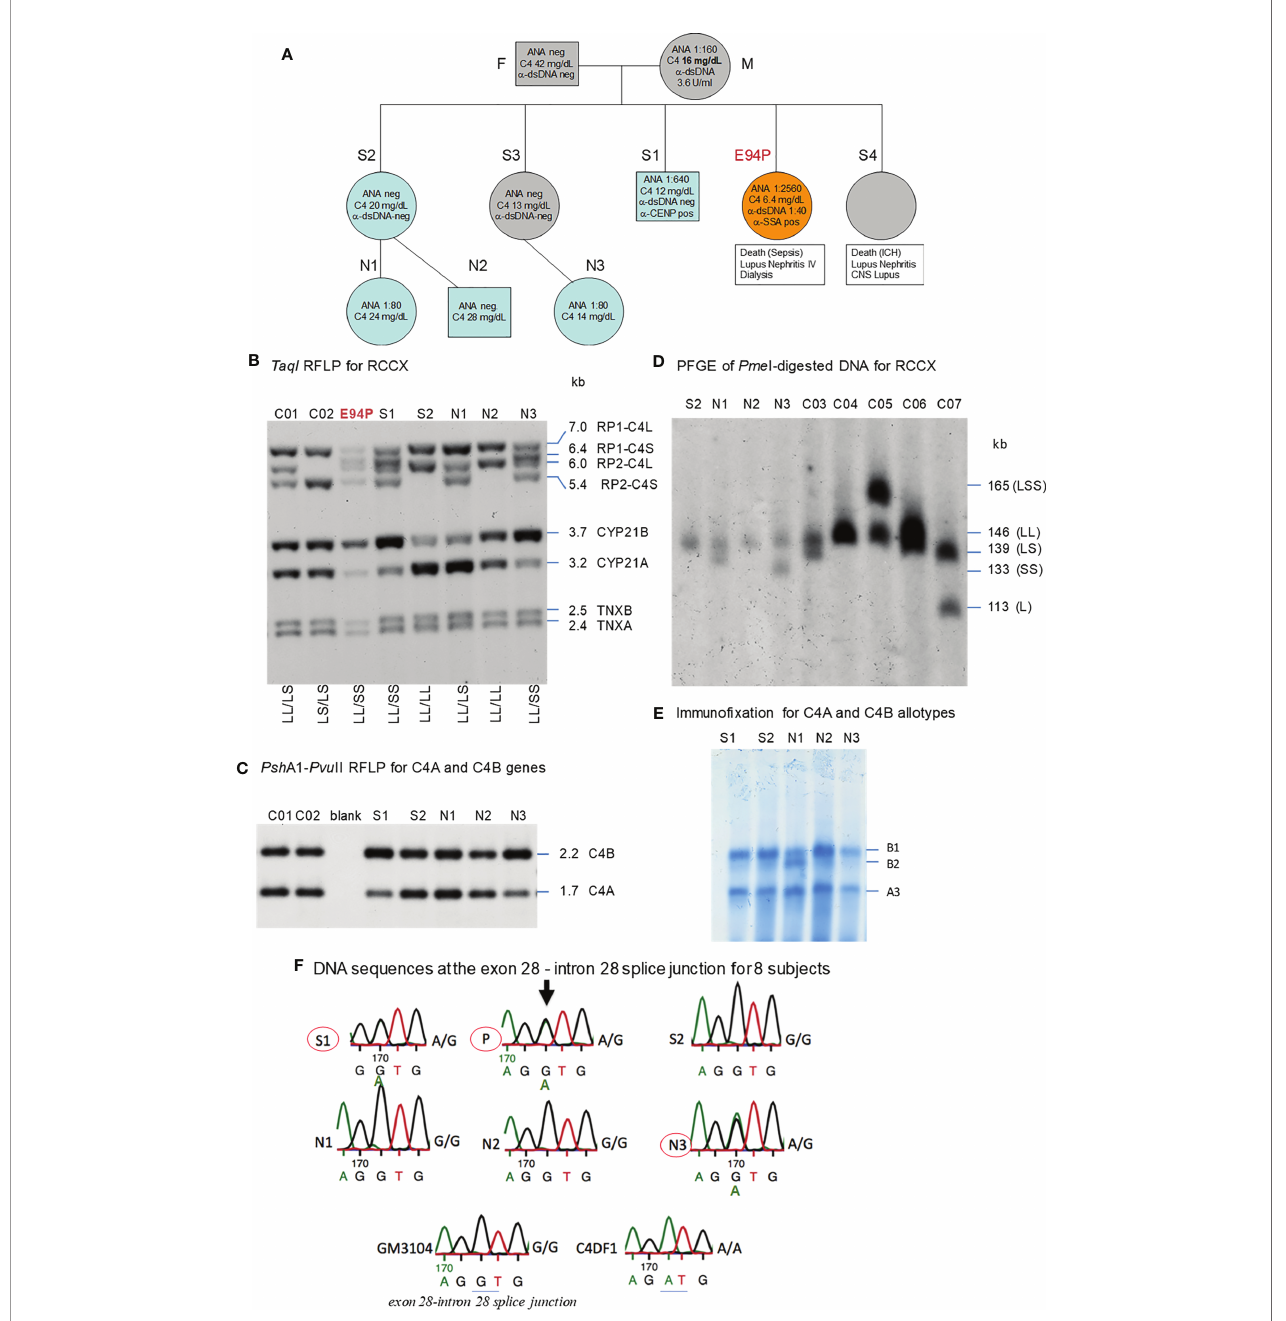
FIGURE 5 | A European family with multiplex SLE-related mortality and low C4 levels (E94). (A) A three-generation family tree. E94P and S4 passed away with lupus nephritis and complications. (B) Taq I RFLP to show RCCX modular structures for six subjects of the E94 family including the index patient E94P, two siblings (S1 and S2), three niece/nephew plus two control subjects (C01 and C02). Note that E94P, S1 and N3 each contained an unusual short-short ( SS ) haplotype for RCCX that had CYP21B-CYP21B con fi gurations ( Table 2 ). (C) Psh AI/ Pvu II RFLP to show the relative dosages of C4A and C4B genes for subjects shown in panel (B) , except E94P as her C4A and C4B genes were determined by real-time PCR. (D) Long-range mapping of the RCCX haplotypes by Pme I-digested genomic DNA in agarose plugs, resolved by pulsed- fi eld gel electrophoresis and hybridized to radioactive probes speci fi c for RCCX genes. DNA plugs for four members of the E94 family were prepared together with four unrelated controls (C03-C07). Subject N3 possessed the LL and SS haplotypes. (E) Immuno fi xation of EDTA-plasma to show C4A and C4B protein variants and their relative expression levels. Subject N3 has similar protein levels of C4A3 and C4B1, although she had LL/SS haplotypes with three copies of C4B gene and one copy of C4A . (F) DNA sequences at exon 28-intron 28 splice junction for six members of the E94 family, plus a C4 complete de fi ciency subject with identical HLA haplotypes (C4DF1), and a normal control (GN3104). Subjects S1, P and N3 had double sequences at the intron 28 splice junction donor site (marked by an arrow for E94P). C4DF1 has homozygous mutations at the same